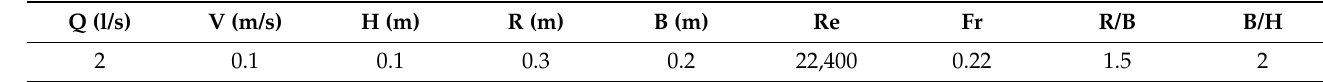
Table 1. Hydraulic conditions for the main